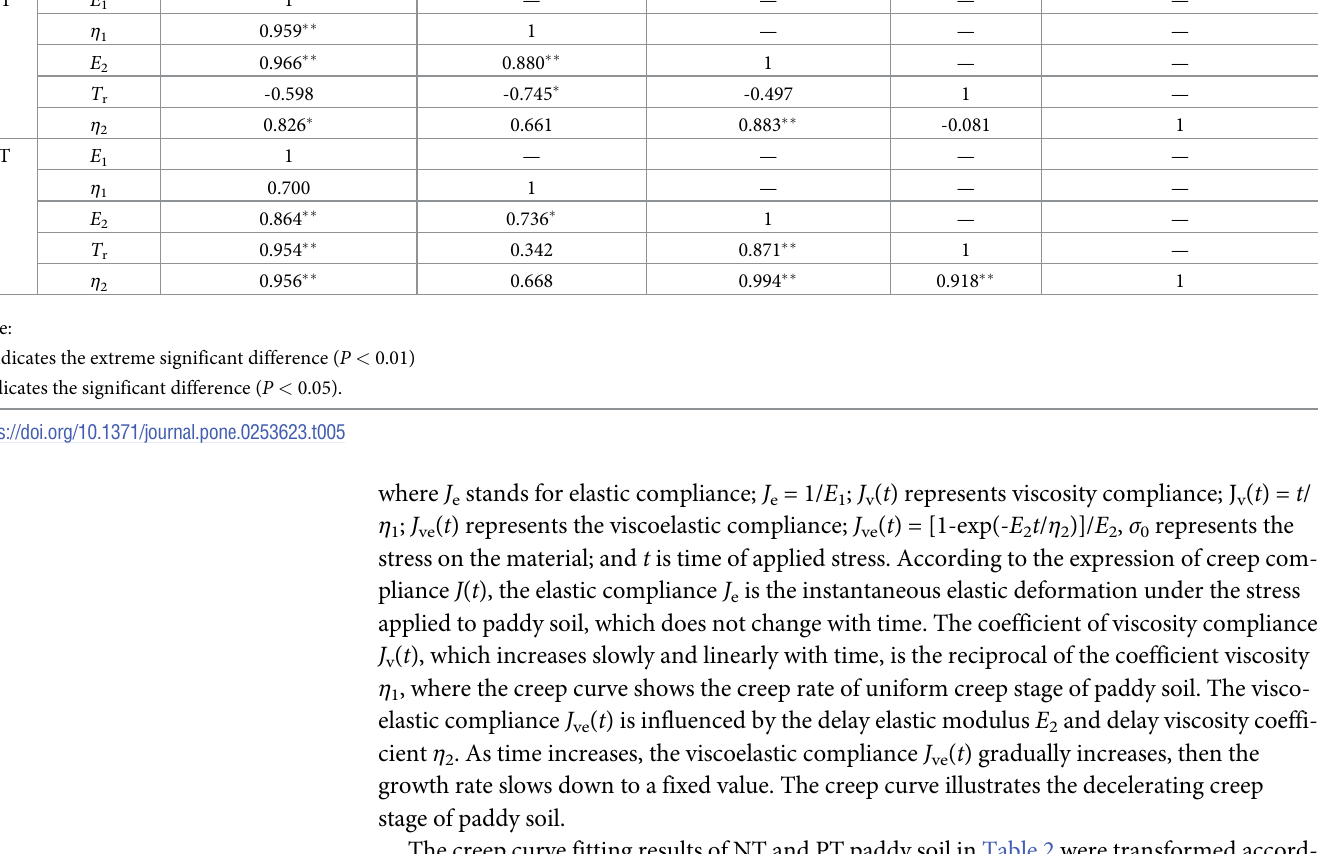
Table 5. Correlation of paddy soil creep parameters.